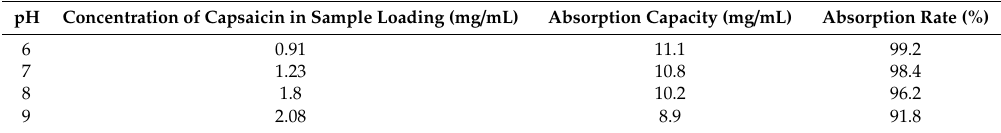
Table 6. E ff ect of the concentration and pH of sample